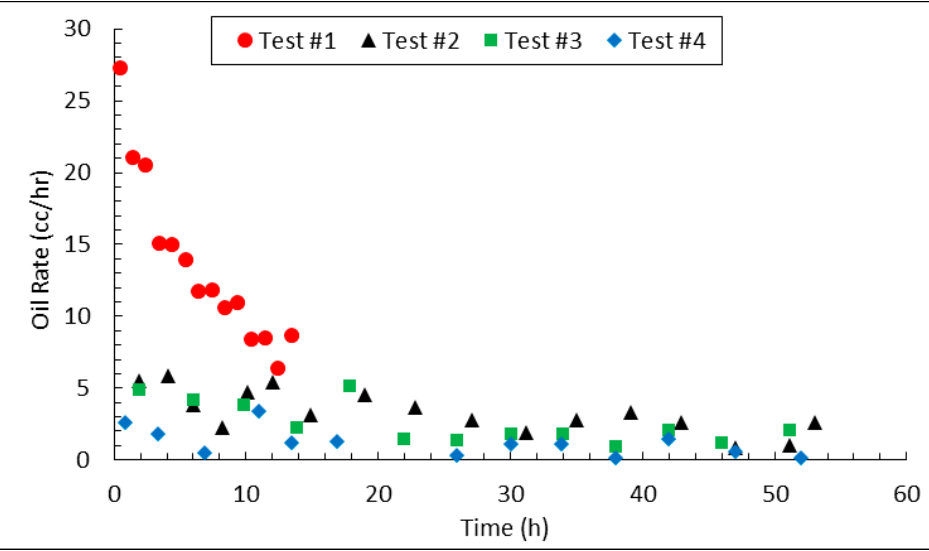
Figure 10. Actual oil production rate data for the experimental cases presented by Ma et al. [3].